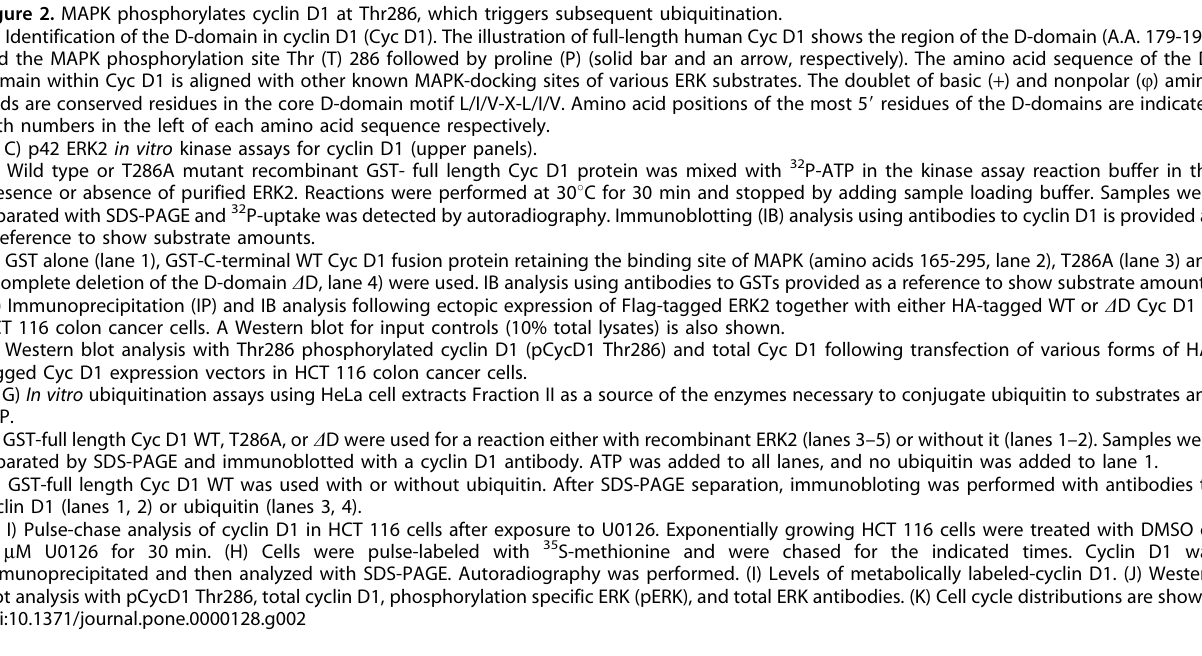
nous expression by the reduced mobility of HA-tagged cyclin D1. We analyzed the phosphorylation status of exogenous cyclin D1 expression at Thr286. Cyclin D1 phosphorylation was significantly